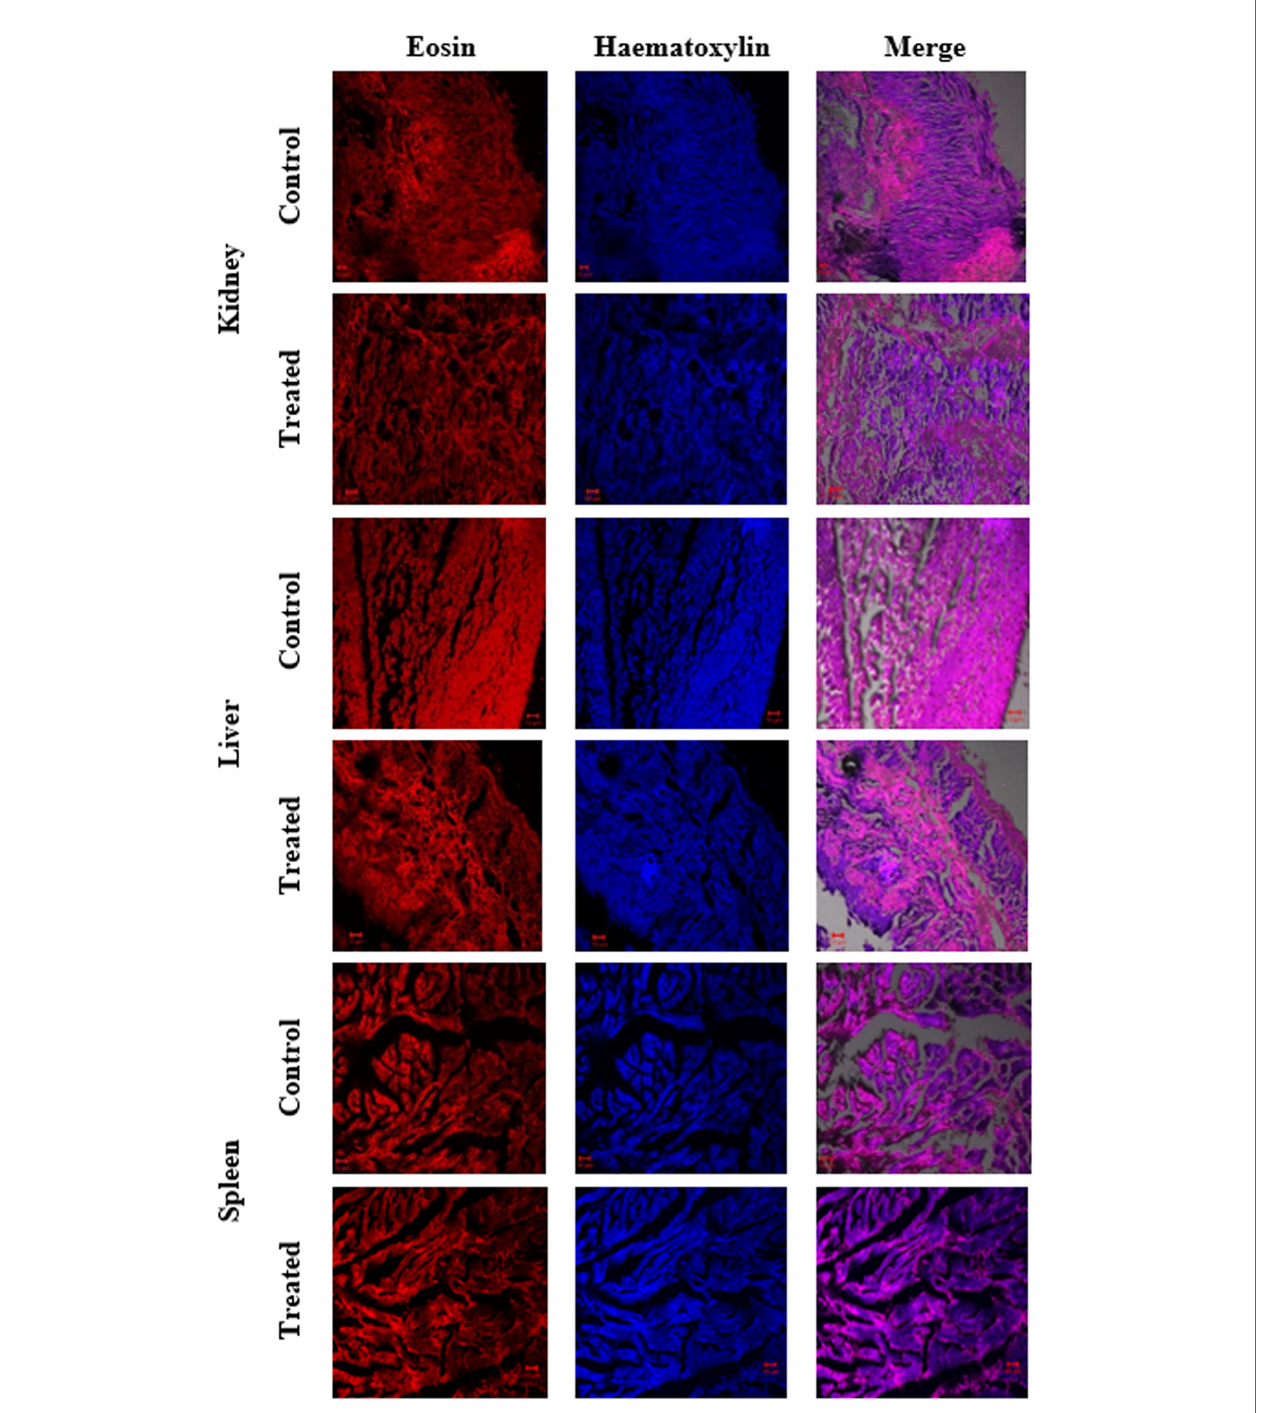
FIGURE 10 | Histological changes in major organs (kidney, liver, and spleen) of control and treated zebra fi sh D. rerio were evaluated after the 21-day exposure of NHP (500 µg/L).